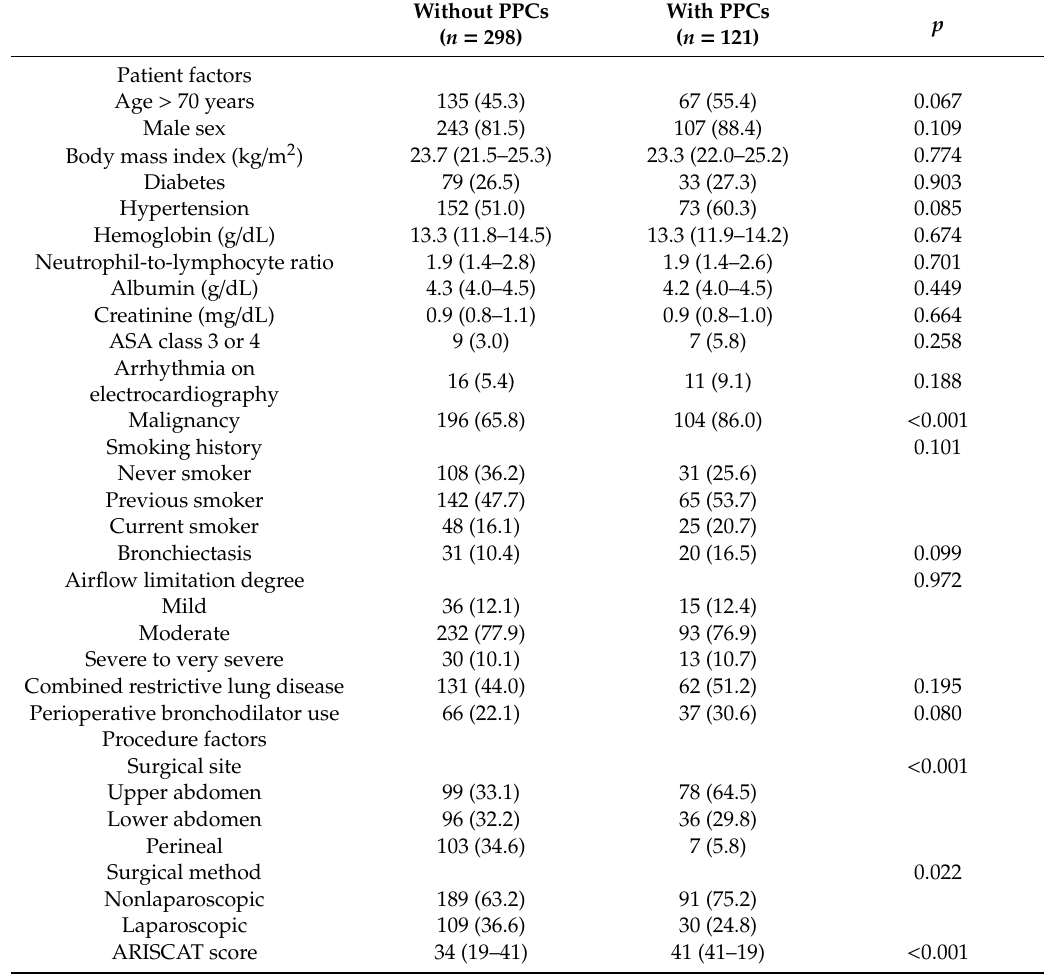
Table 1. Preoperative variables of the